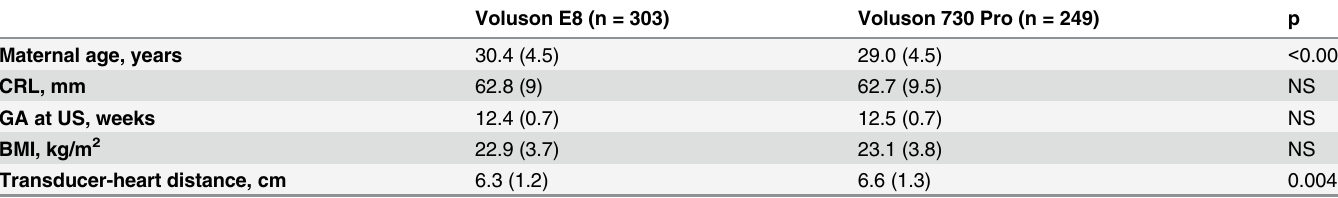
Table 1. Baseline characteristics of patients according to the type of ultrasound machine used for evaluation of the fetal